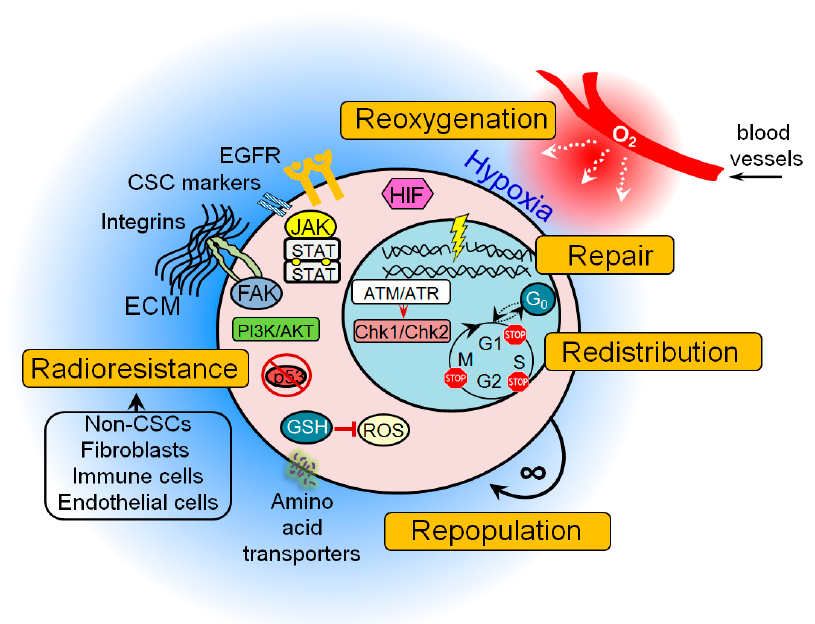
Figure 1. The general mechanisms of cancer stem cell (CSC) radioresistance. Many protective mechanisms are activated in CSCs that result in treatment resistance. These include intrinsic determinants (activation of the pro-survival pathways, enhanced DNA repair capability, protection against oxidative stress, unlimited self-renewal potential, impaired cell cycle arrest, and apoptosis) and extrinsic determinants such as hypoxic microenvironment and a protective CSC niche consisting of the cellular components (e.g., non-CSCs, fibroblasts, immune cells, endothelial cells), soluble factors (e.g., growth factors, hormones and cytokines), and extracellular matrix. ATM—ataxia–